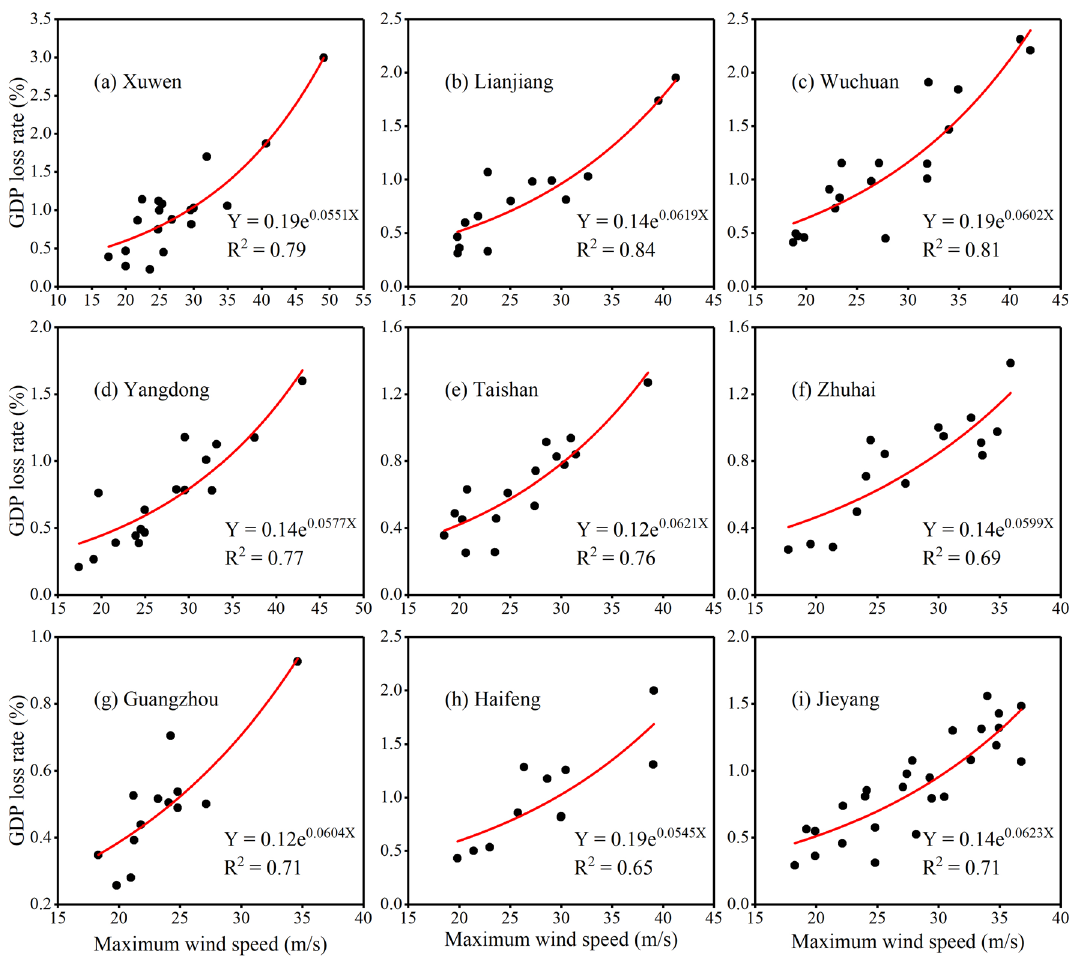
Fig. 4 Direct economic loss rates in GDP fitted with maximum wind speed (MWS) by an exponential function in nine coastal districts from south to north in Guangdong